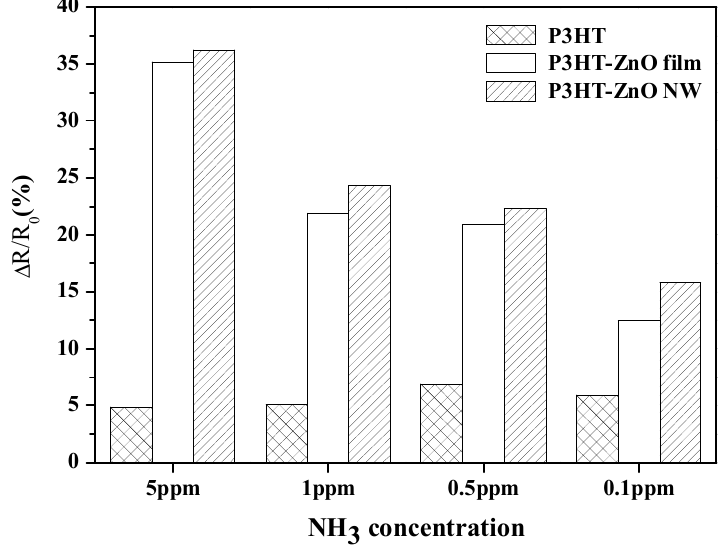
Figure 9. The comparisons of the responses of P3HT, P3HT-ZnO film and P3HT-ZnO nanowires when all P3HT films were produced by the spin coating in 4000 rpm. Table 1. Sensing properties of the presented sensor in this work compared with other ammonia gas sensors (previous